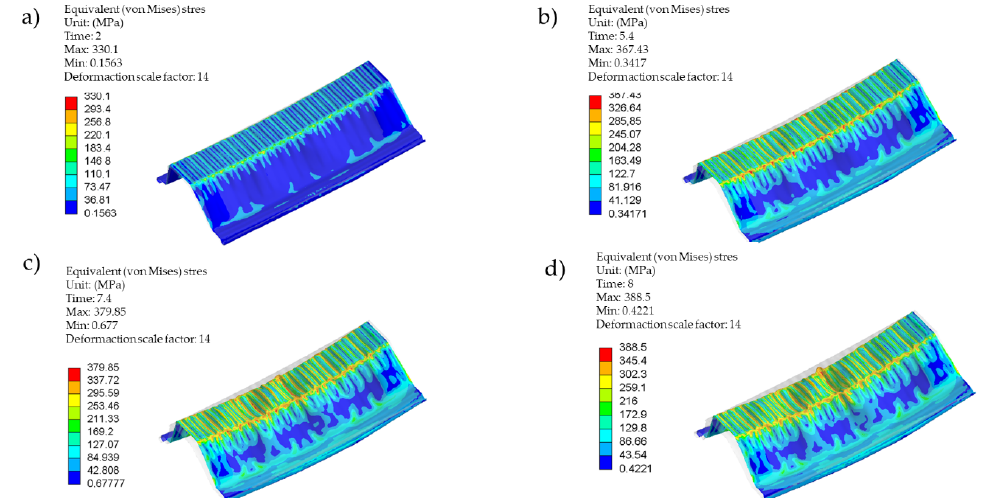
Figure 15. The stress maps and the test model deformation at the reference load stages, ( a ) stage 1: time 2.0, ( b ) stage 2: time 5.4, ( c ) stage 2: time 7.4, ( d ) stage 3: time 8.0. Materials 2021 , 14 , x FOR PEER REVIEW